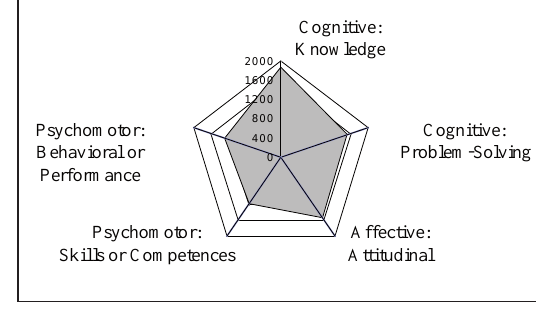
Estimated learning points with respect to efficacy for all learning experiences: They were calculated by multiplica- tion of the estimated learning time (hours/year) with the perceived appropriateness of the educational strategies (rated from 0 to 3) for each particular learning experience followed by addition of the figures and plotting of the sums for each dimension of educational objectives; scale 0-2000, interval 400; mean ± SD 1484 ± 264 of all five dimensions. The data illustrate an appropriate balance between the different types of learning objectives for the overall postgraduate training